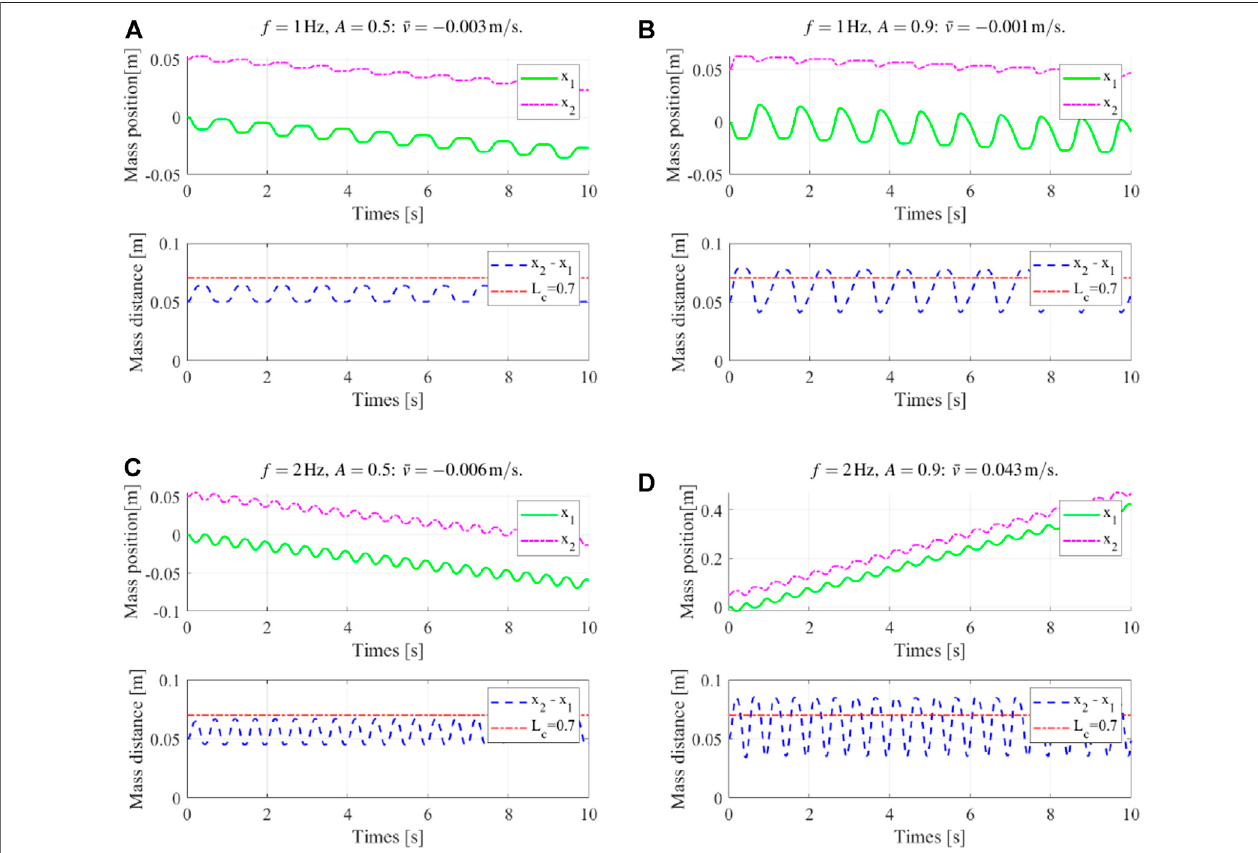
FIGURE5| Typicallocomotion results usingthecompoundfrictionforce. (A) and (B) “ compositegait ” weakeningthe “ primitivegait ” locomotion result,whileithas not reversed the locomotion direction; (C) and (D) “ composite gait ” reversing the “ primitive gait ” locomotion